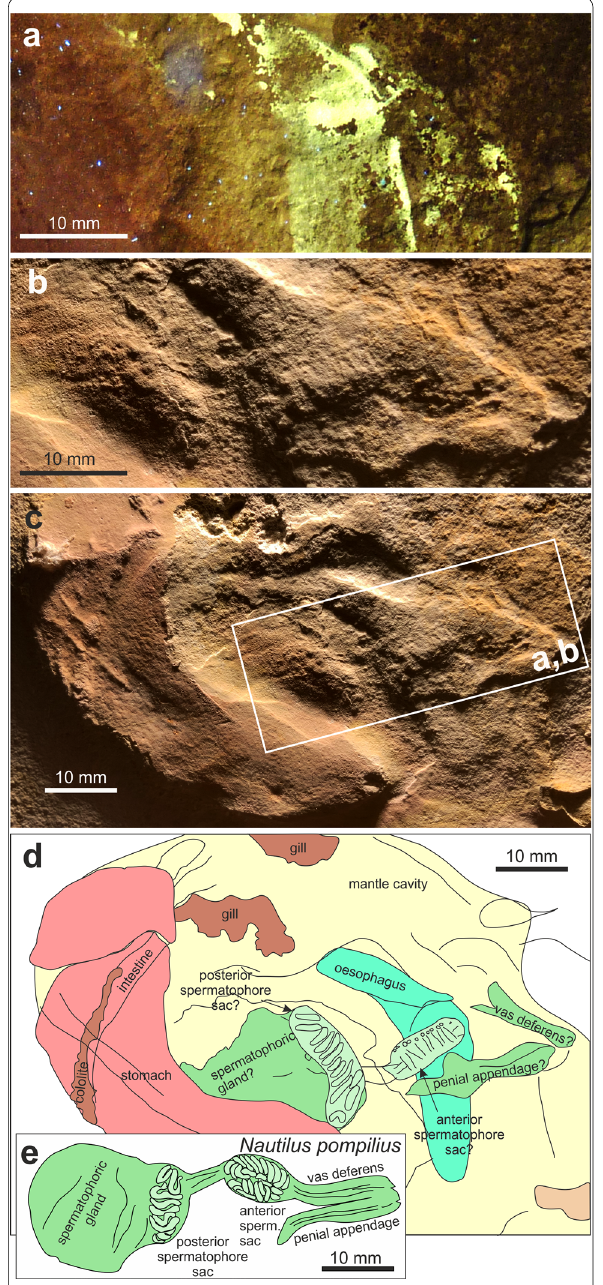
Fig. 3 Detail of the soft parts of Subplanites sp. to show details of the reproductive organs (green colours). a Detail of the photo in b taken with UV‑light; the fluorescent structure is part of the crop. b Like a , with white light. c Photo taken under shallow white light to show the remains of what might be reproductive organs. d Line drawing of the structures visible in the b with possible interpretations. e Drawing of the male reproductive organs of Nautilus pompilius (after Sasaki et al. 2010: Fig. 12E)